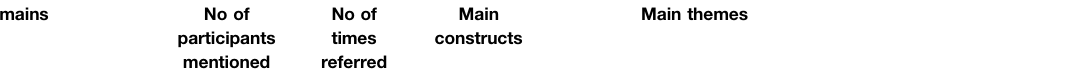
TABLE 4 | ( Continued ) Enablers to patients ’ adherence to the evidence-based guideline recommendations for venous leg ulcer